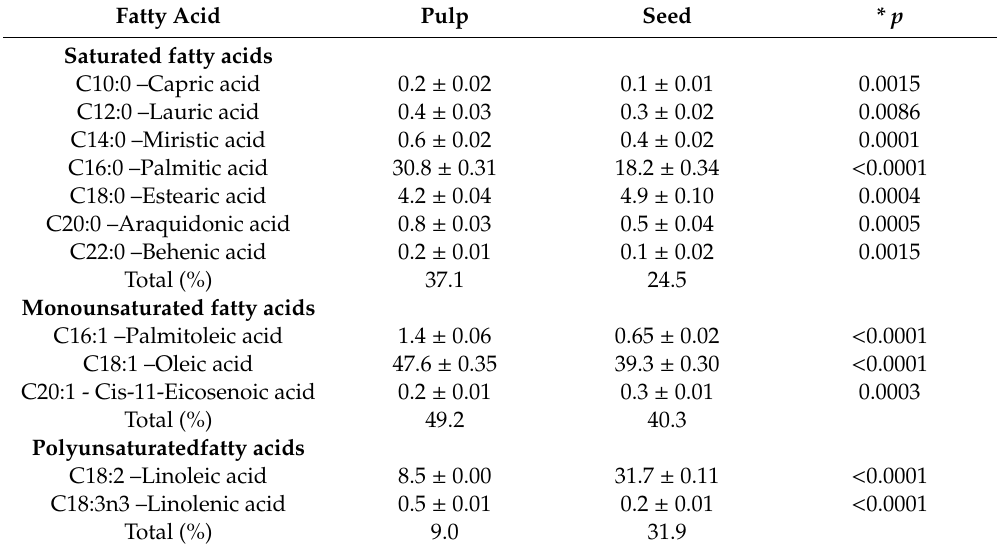
Table 4. Fatty acid distribution (%) in pulp and seed of B.